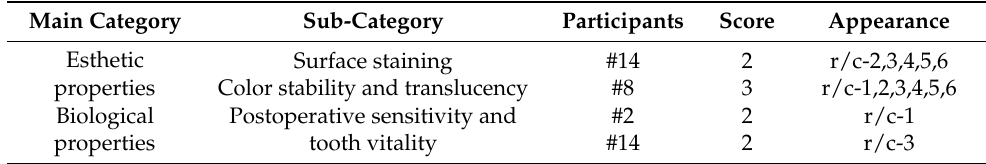
Table 7. Complications of a single crown (n = 15) during 6-month follow-up evaluation.